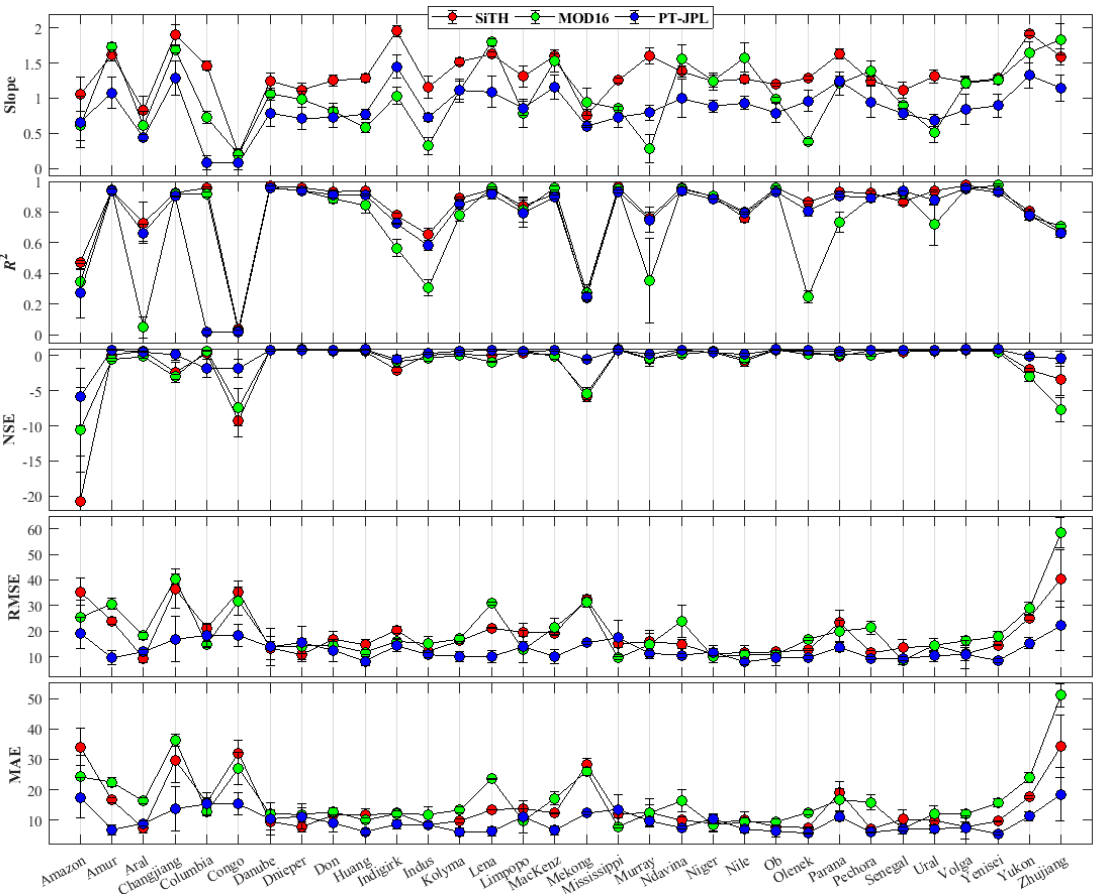
Figure 5. Comparison of the simulated ET of three models versus water balance ET at 32 catchments. The bottom, middle, and top panels represent the slope, R 2 , and NSE, respectively. The dots are the median of simulated ET under different forcing datasets. Error bar illustrates the mean ± 1 s.d.